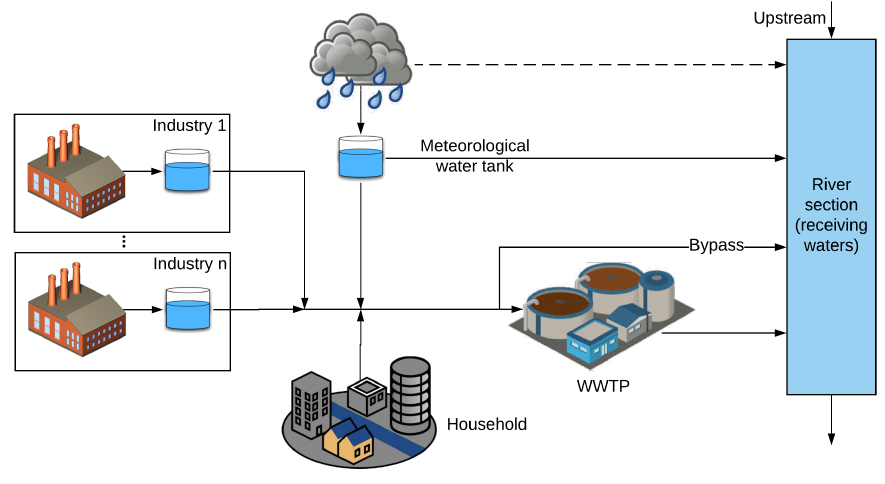
Figure 1. River basin case